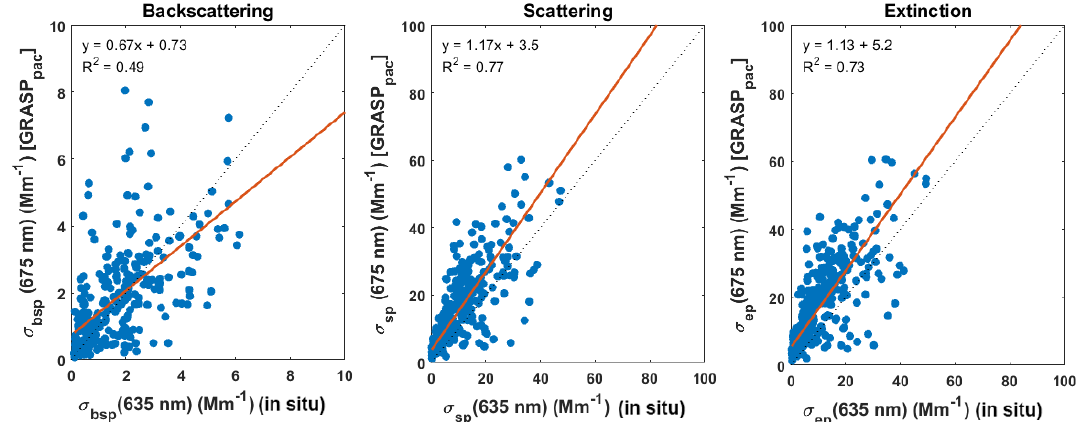
Figure 1. Scatter plots of the hourly averaged aerosol light-backscattering, scattering and extinction coefficients determined with GRASP pac from the ceilometer and photometer data at MSA height versus the measured in situ coefficients. This comparison is restricted to situations with low ambient RH (RH ambient < 50%). The linear regression and the 1:1 line are also shown.